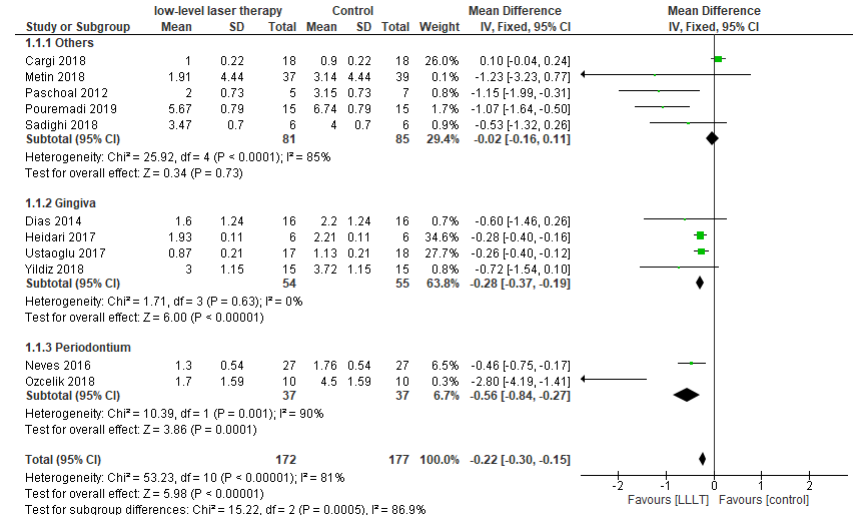
Figure 4. Post-operative analysis of pain intensity (VAS) 14 days